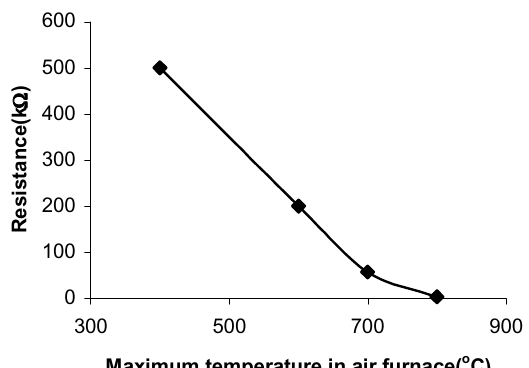
Figure 1. The paste resistances at different sintering temperatures in air.